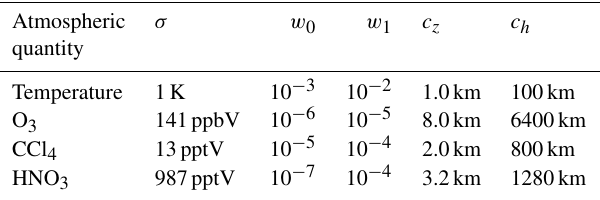
Table 1. Standard deviations and vertical ( c z ) and horizontal ( c h ) correlation lengths used for the tomographic